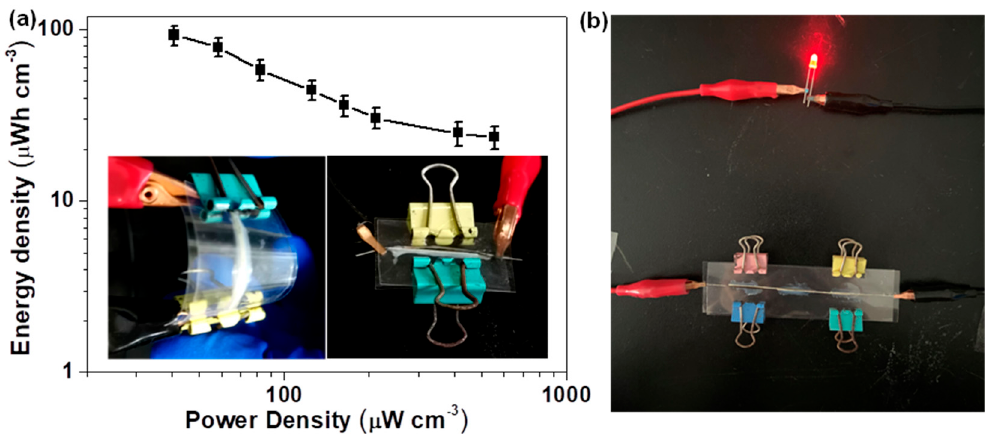
Figure 8. ( a ) Ragone plot of the currently developed FSSC cell and its optical pictures under natural and curved conditions; ( b ) optical image of a glittering LED bead well driven by three serial-connected FSSC cells.